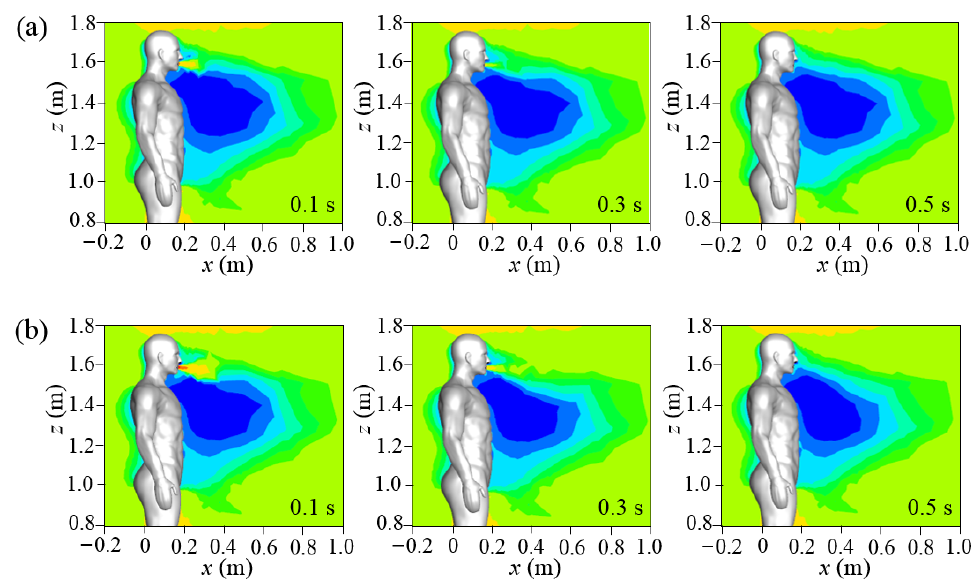
Figure 7. Wind fields of different cough conditions under V in = 1.8 m/s: ( a ) standard cough jet at different times; ( b ) double-strength cough jet at different times.